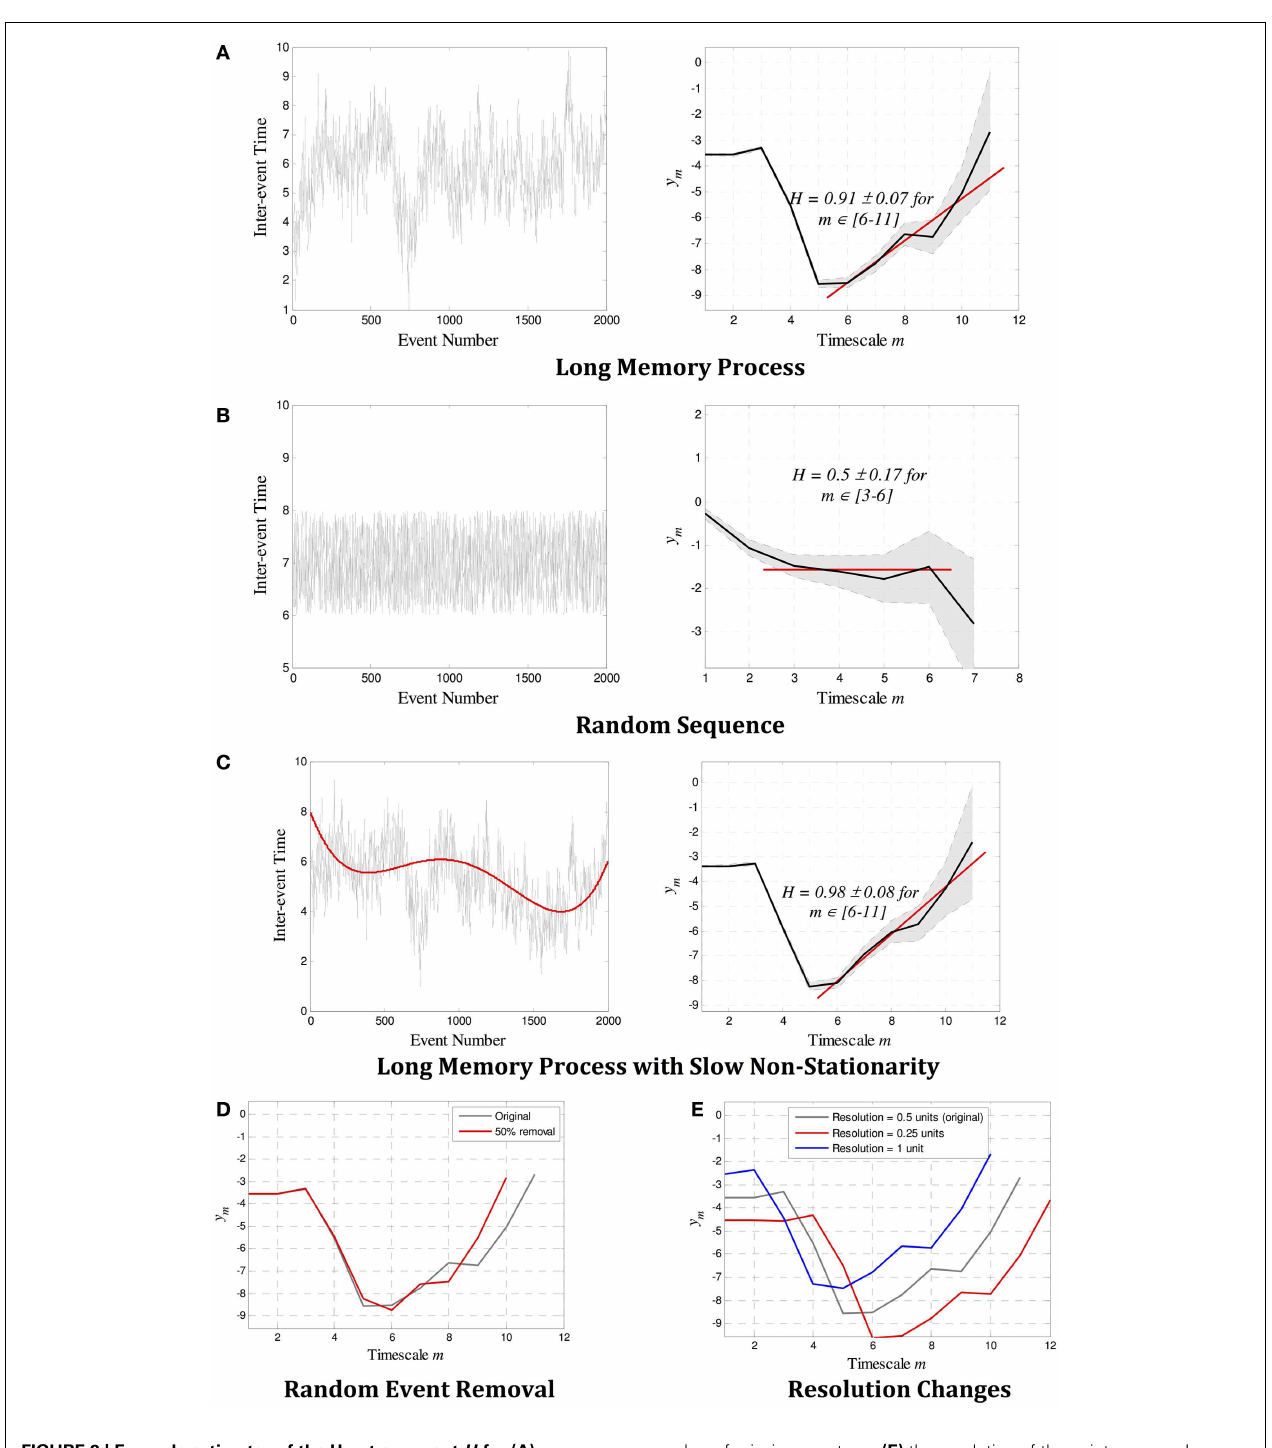
FIGURE 2 | Example estimates of the Hurst exponent H for (A) a long-memory process with H = 0.9 , and (B) a random process with H = 0.5 . In each case, the scalogram (a log–log plot of m versus y m ) shows a region of alignment of at least four scales that correctly identifies a power law with gradient β and H = 0.5( β + 1). (C–E) show the robustness properties of wavelet estimation tools.The gradient β (and therefore H ) is not affected by (C) slow non-stationarity, (D) a large